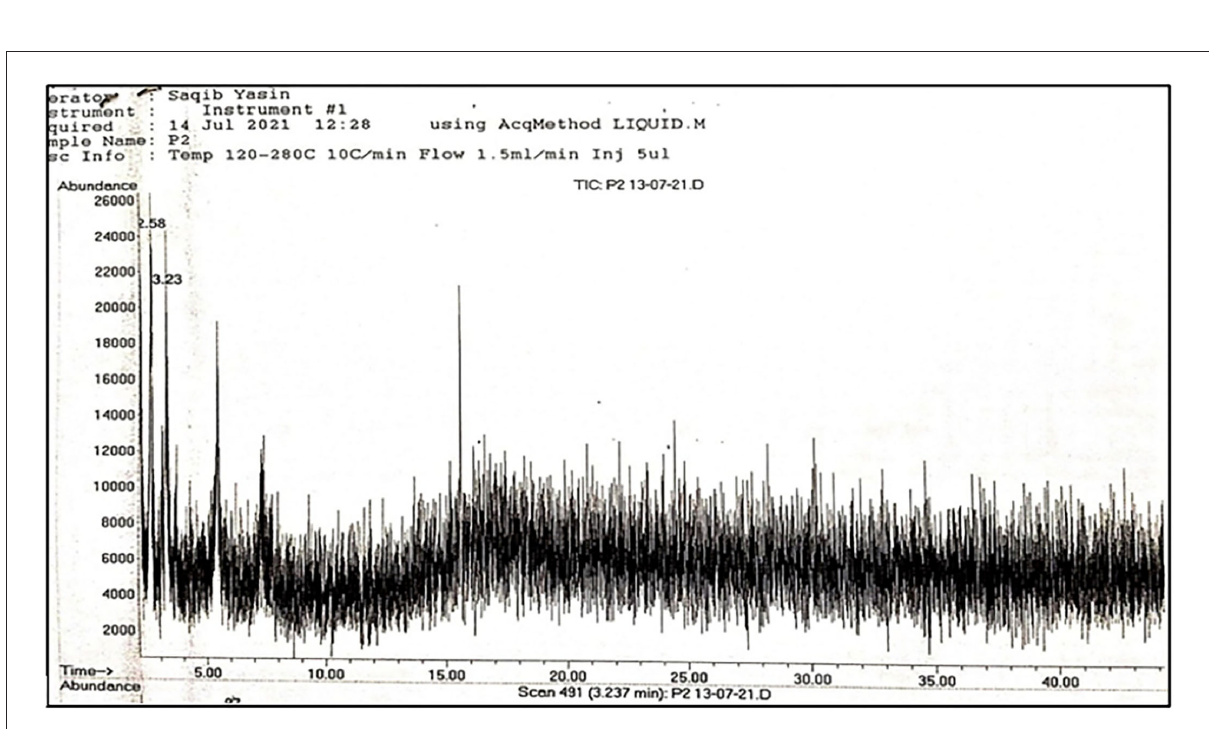
FIGURE1 Total spectrum obtained through GC-MS of leaf